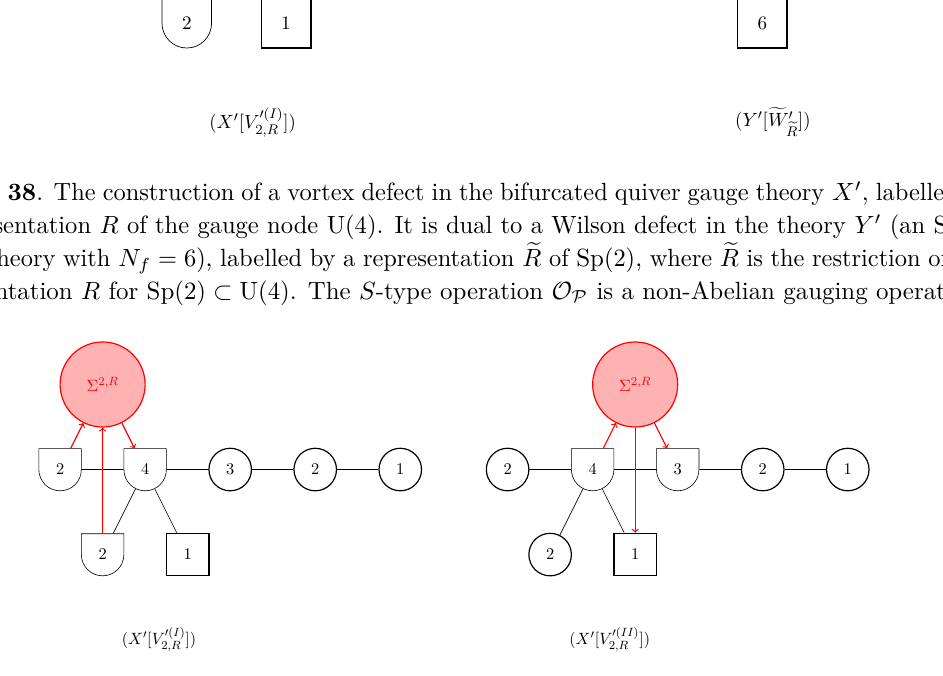
Figure 39 . Different coupled 3d-1d quivers realizing the same vortex defect in the bifurcated quiver in the Sp(2) gauge theory Y 0 . The Witten indices for X 0 , which is dual to the Wilson defect f W 0 e R the SQMs in the two cases are computed in the ξ > 0 and ξ < 0 chambers